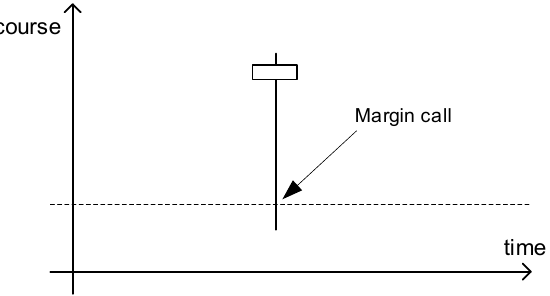
Figure 3. An increase candle with a significant fall “inside”.